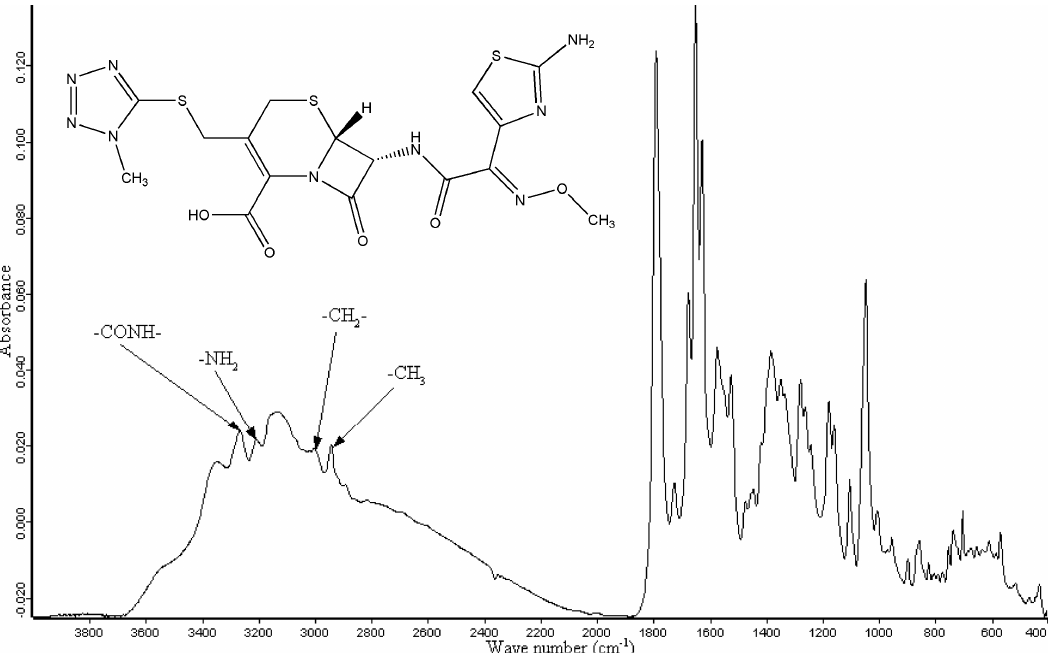
Fig. 3. IR spectrum of cefmenoxime hydrochloride for injection.